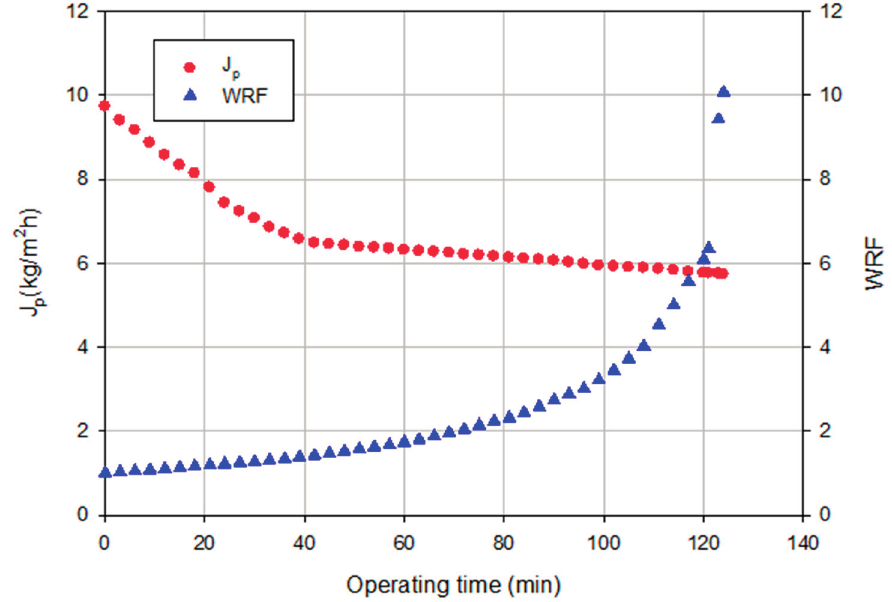
Figure 5. Nanofiltration (NF) of clarified artichoke extract with NP030 membrane. Time course of permeate flux and weight reduction factor (WRF) (batch